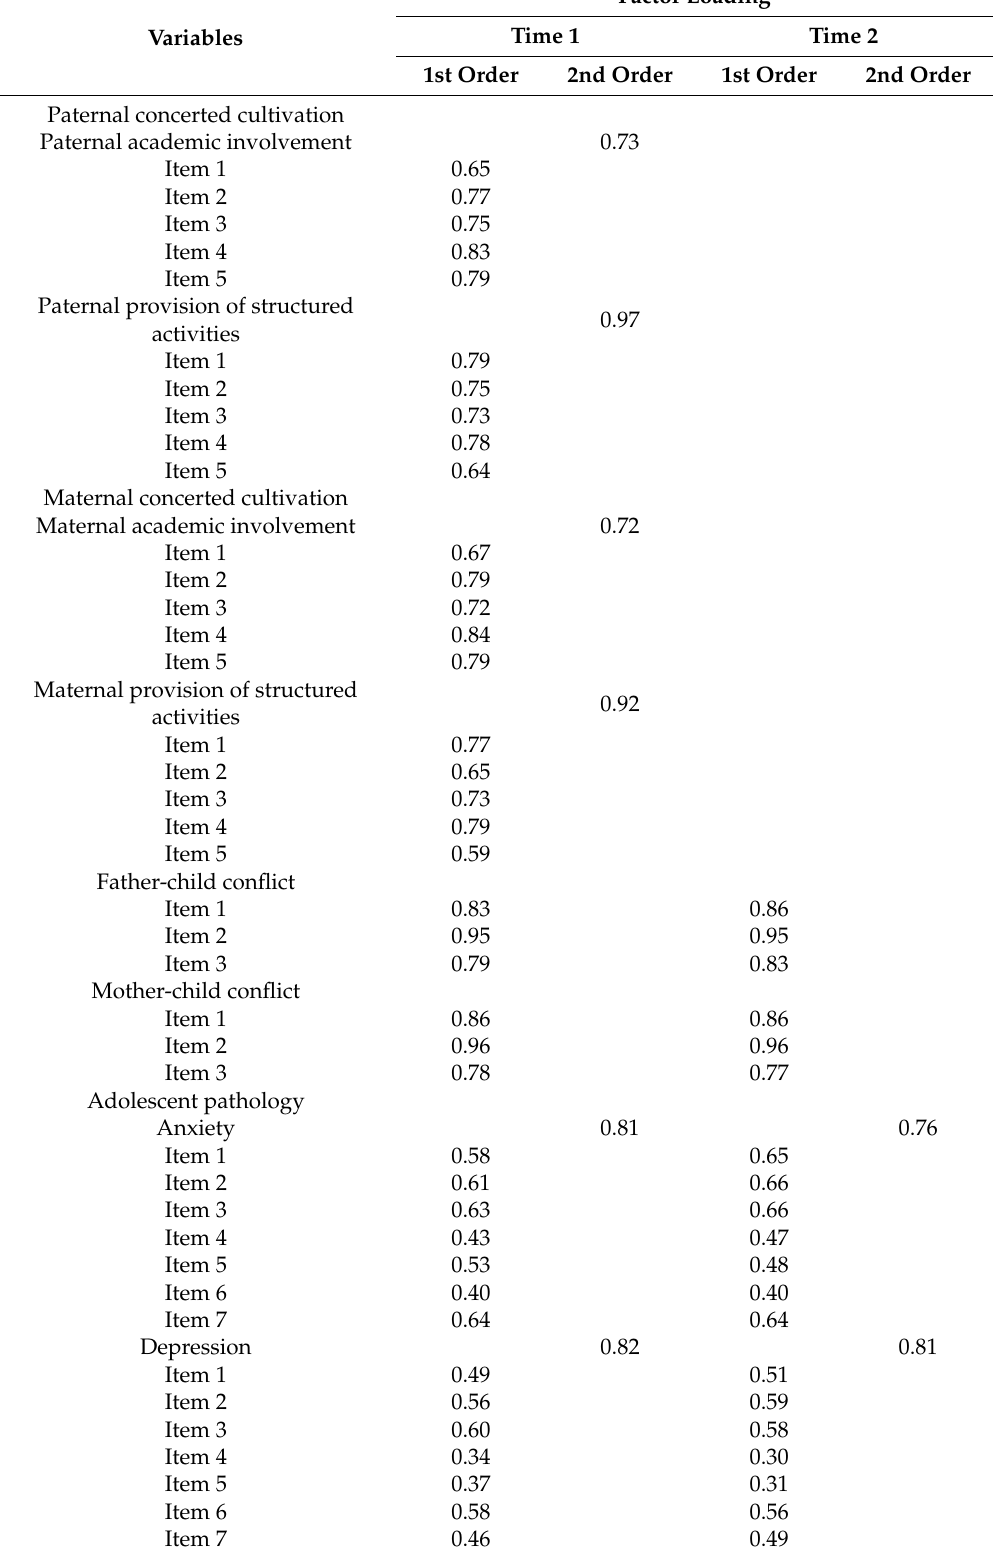
Table 4. Factor loadings of the studied